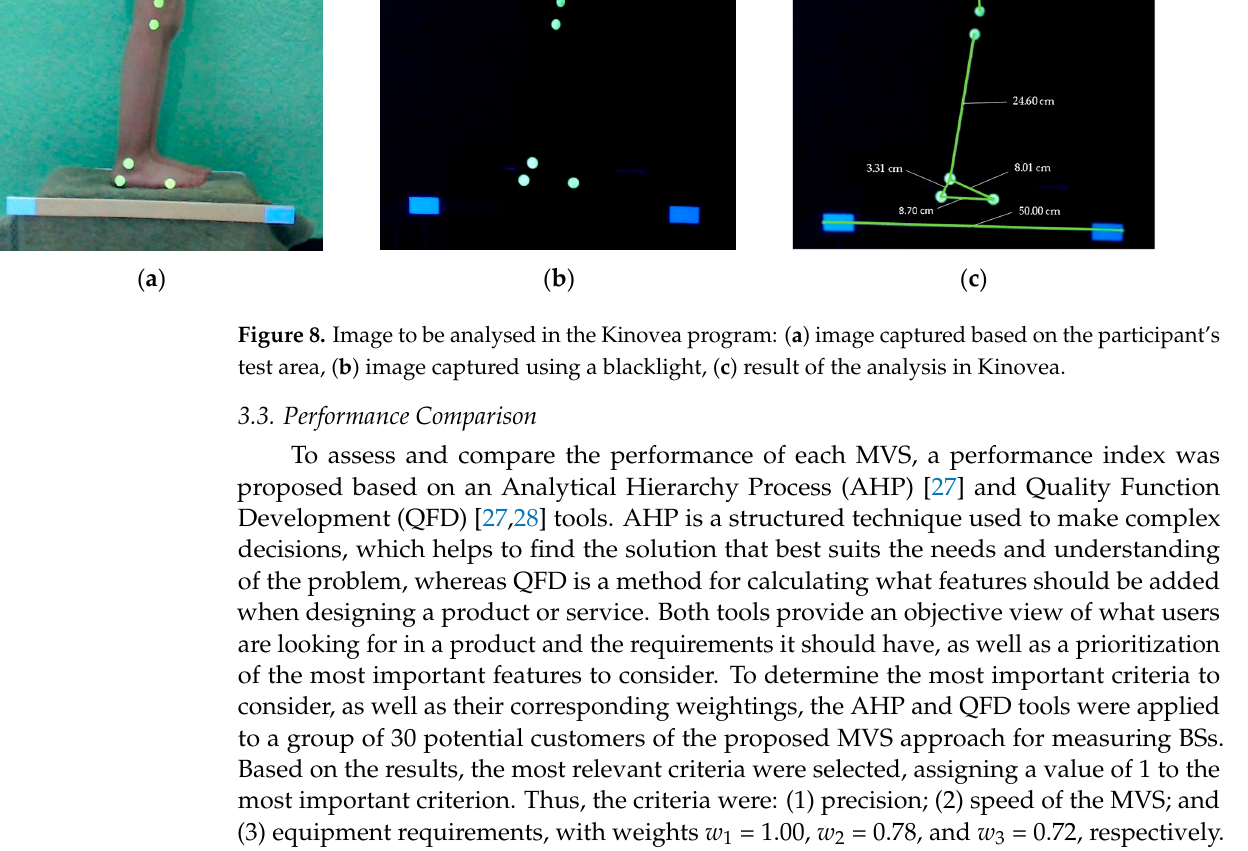
10 of 14 Figure 7. 3D reconstruction error as a function of the image size.